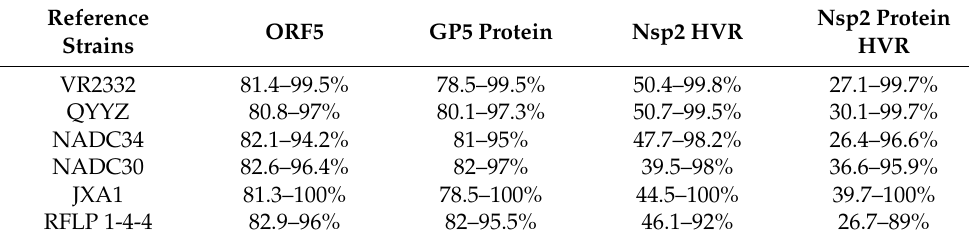
Table 2. Nucleotide and deduced amino acid identity analysis based on ORF5 and Nsp2.